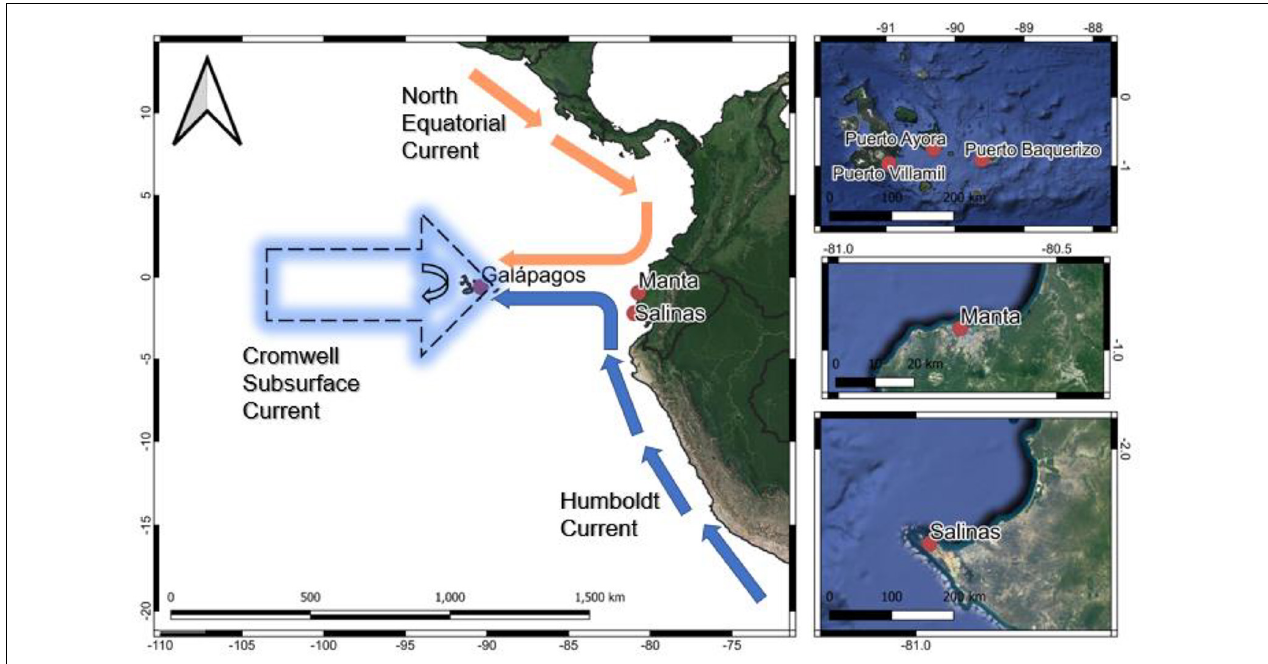
FIGURE 1 | Data collection sites and associated surface current